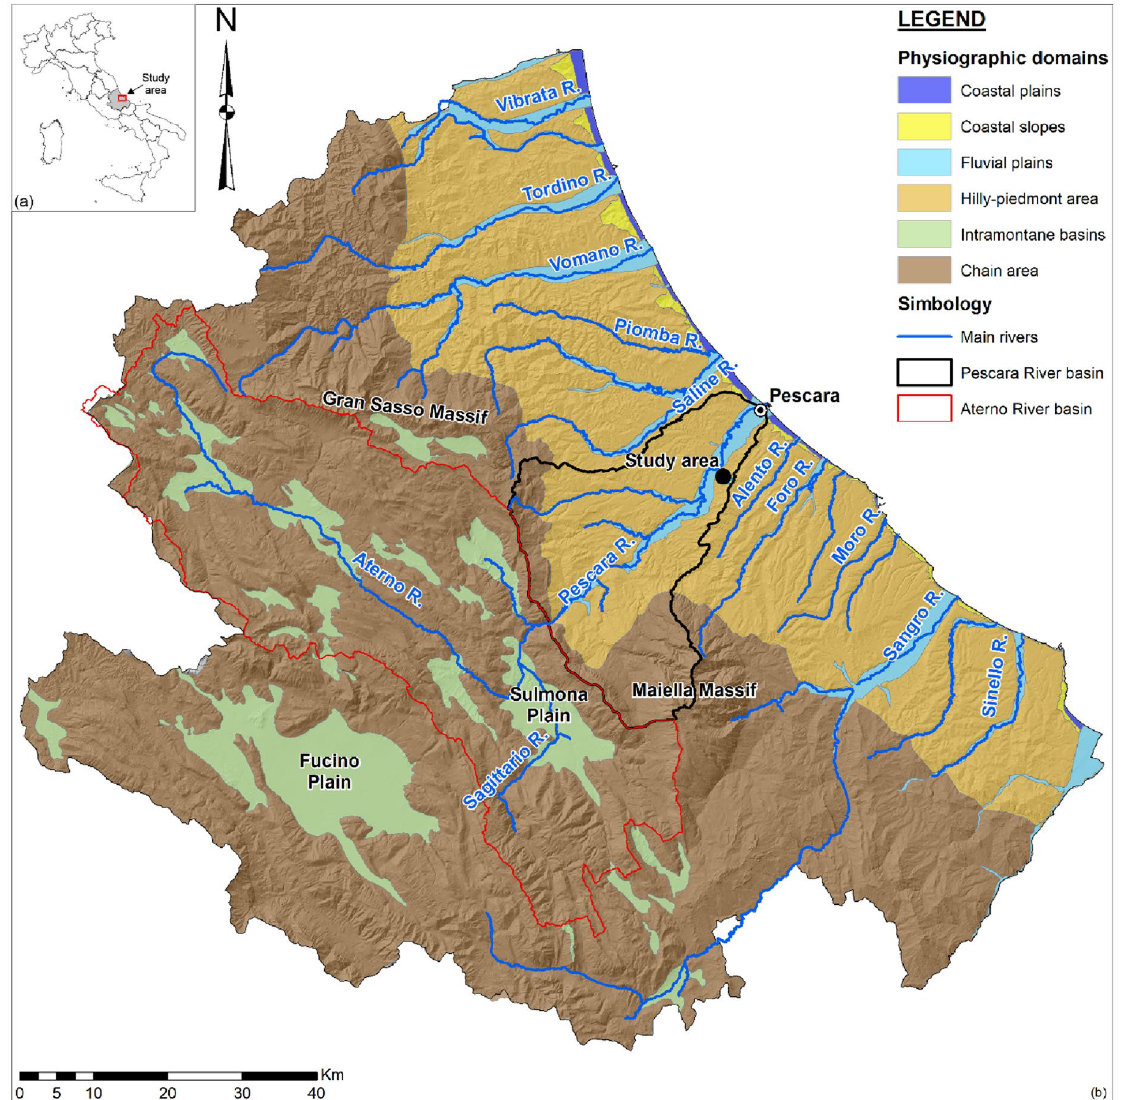
Figure 2. ( a ) Location map of the study area in the Central Italy; ( b ) main physiographic domains of Abruzzo Region. The maps were created by Esri ArcGIS ® 10.6 software (www. esri. com/ en- us/ store/ overv